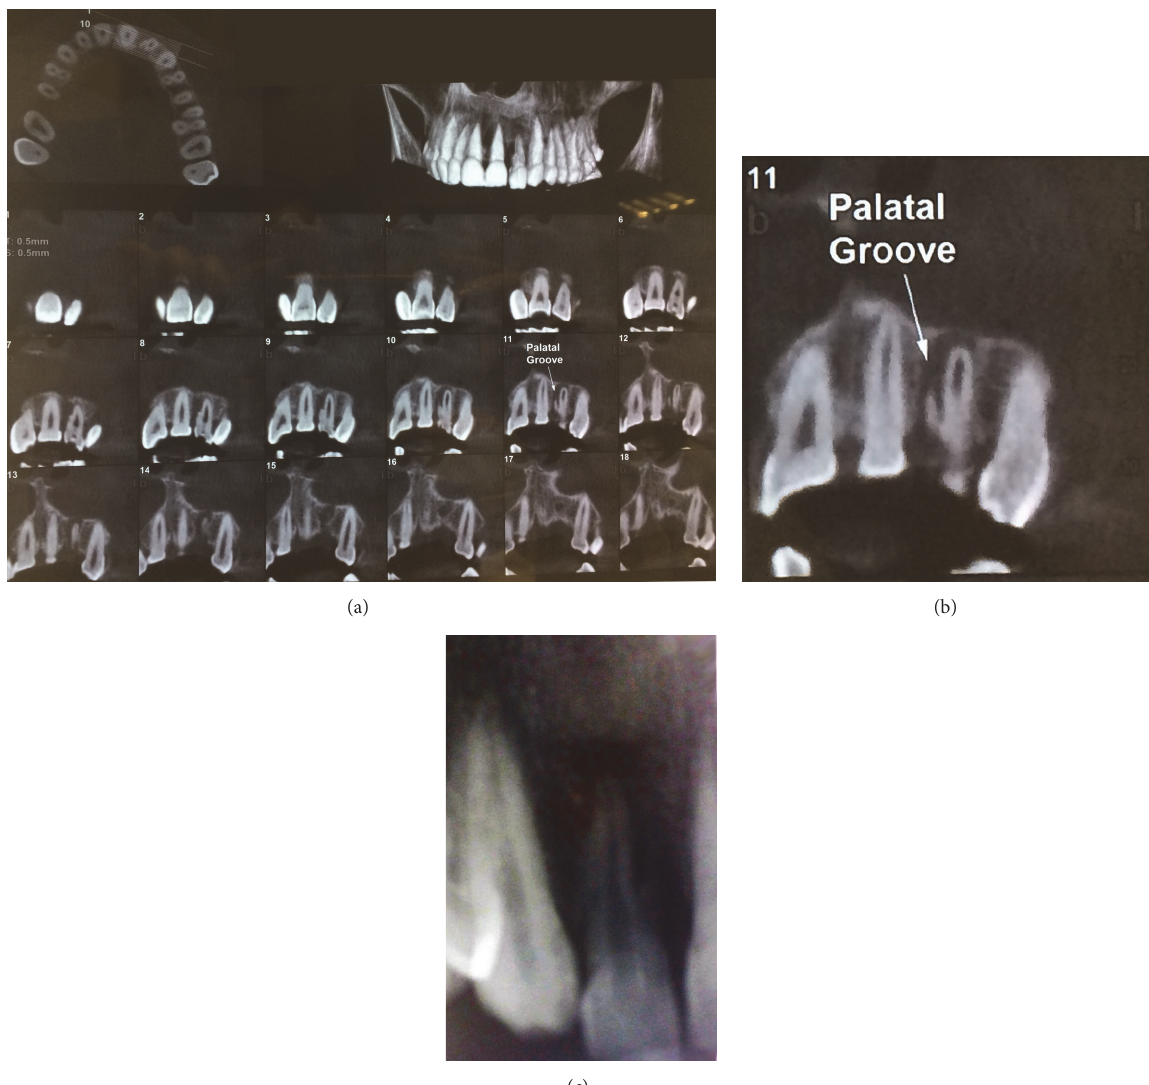
Figure 2: (a) Preoperative cone beam computed tomography (CBCT); (b) CBCT revealed a radicular groove on tooth #10; (c) preoperative periapical radiograph, there is a large radiolucency in relation to left lateral incisor.